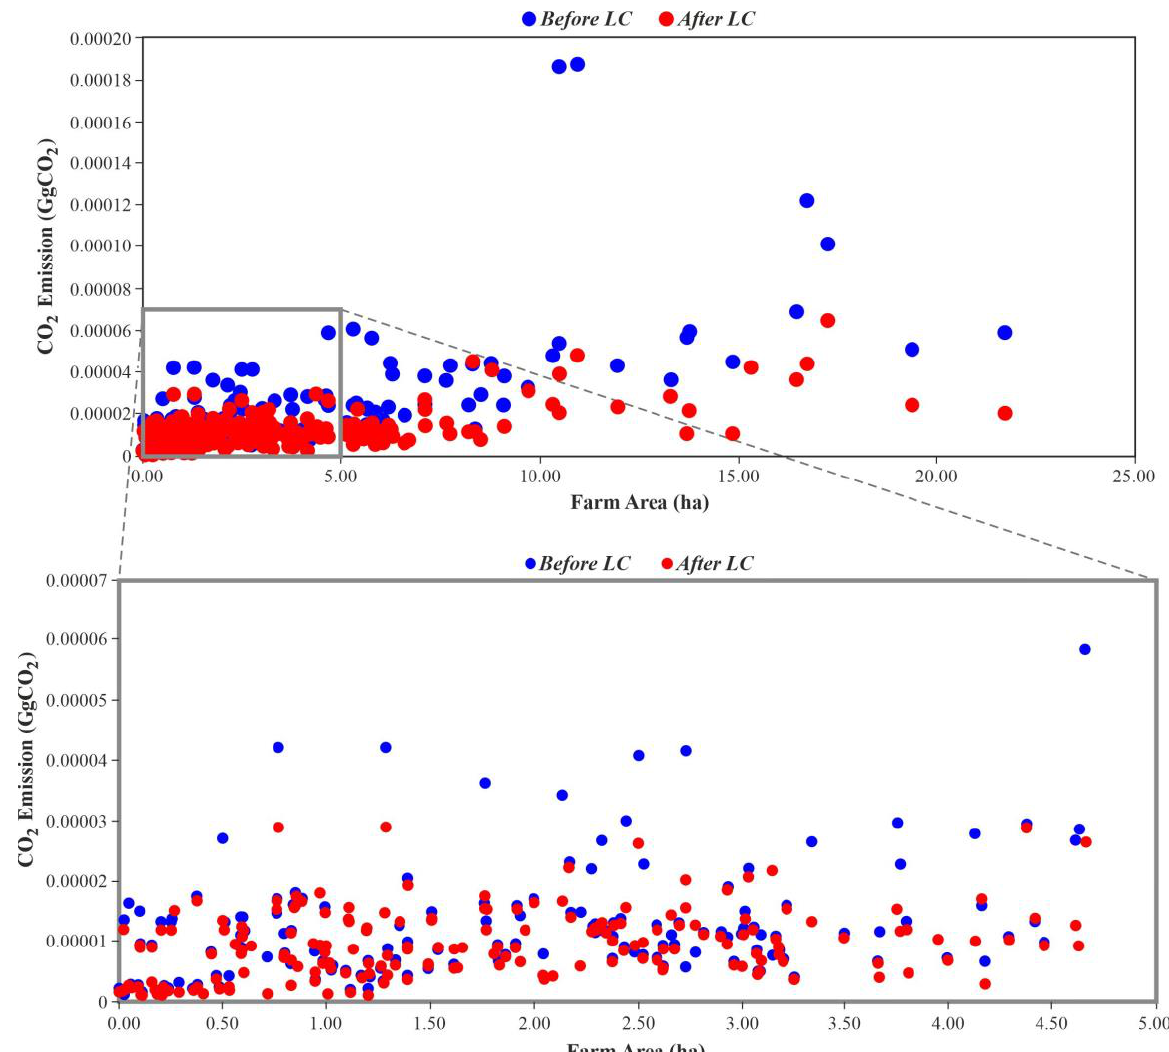
Figure 8. Changes in carbon footprint according to enterprise areas before and after LC (Selimiye Neighborhood).